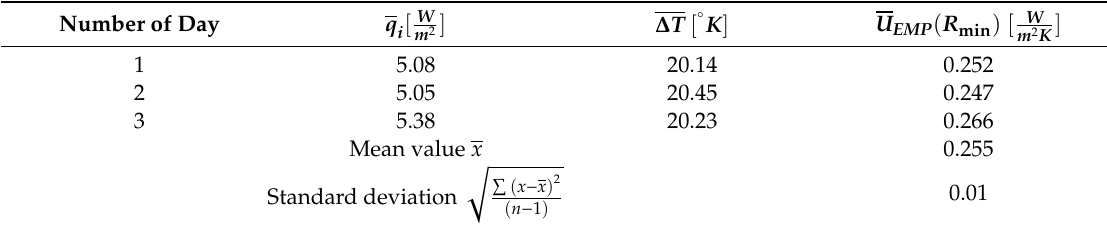
Table 3. Averaged daily values of heat flux density, outdoor air temperature and empirically determined heat transfer coe ffi cient in “solar profit”